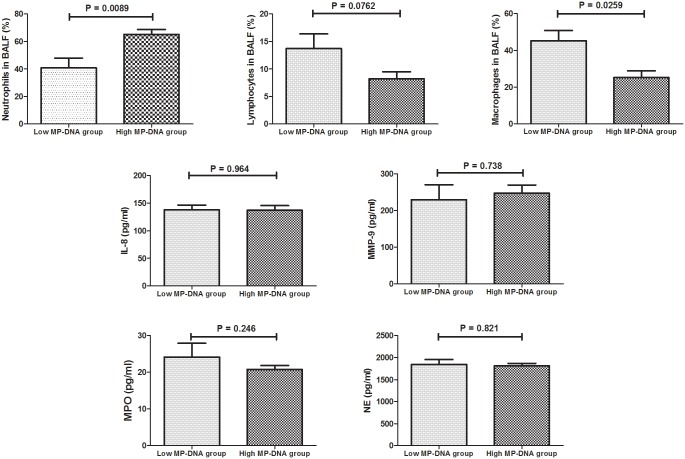
Comparison of Cytology, IL-8, MPO, MMP-9, and NE in BALF between the Low MP-DNA Group (< 107 copies/ml) and High MP-DNA Group (≥ 107 copies/ml).The values in the graphs represent the mean ± SD. The P values were calculated using Student’s t test while Mann-Whitney U-test was used for comparison of MMP-9 between two groups. MPP: Mycoplasma pneumoniae pneumonia; IL: interleukin-8; MPO: myeloperoxidase; MMP-9: matrix metalloproteinase 9; NE: neutrophil elastase.